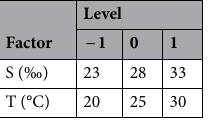
Table 5. Factors and levels table of